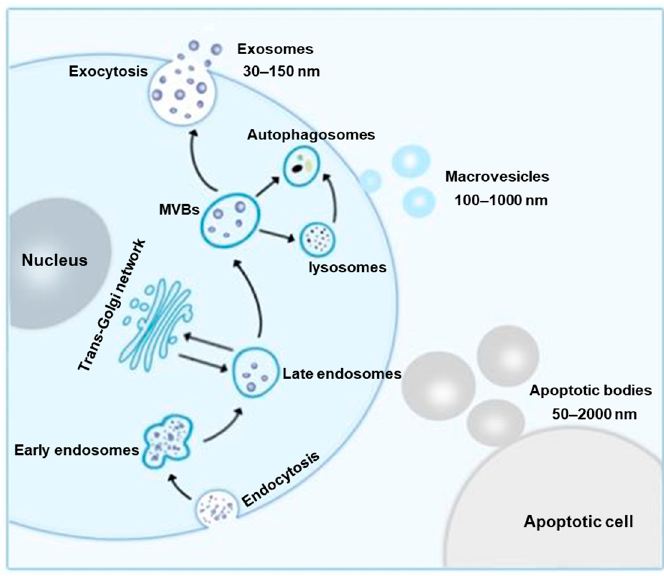
Figure 1. Biogenesis and classification of exosomes. Early endosomes are formed through the invagination of the plasma membrane. As endosomes mature, numerous multivesicular bodies (MVBs) can arise by the inward budding of the late endosomal limiting membrane. Finally, the MVBs can fuse with plasma membranes to release contained exosomes. Microvesicles are generated directly from the out budding of the plasma membrane. Apoptotic bodies are formed by apoptotic cell during shrinkage and death.